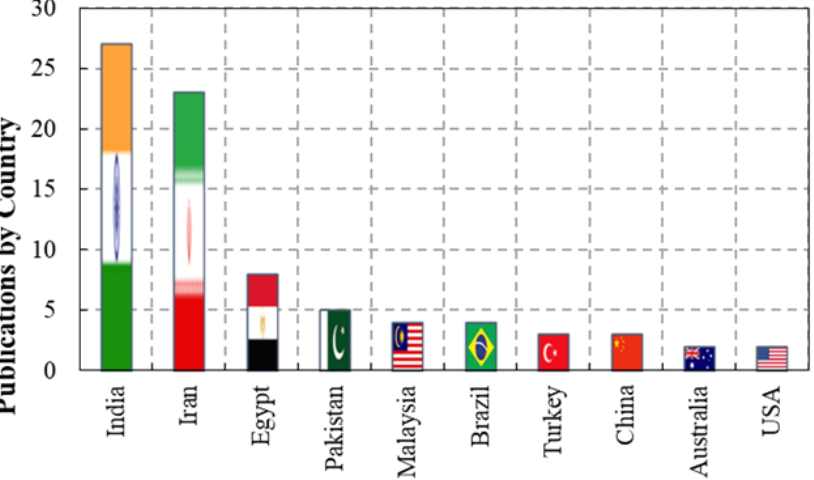
Figure 4. Countries with the most publications in the field of simultaneous DG-SCB allocation in distribution networks.